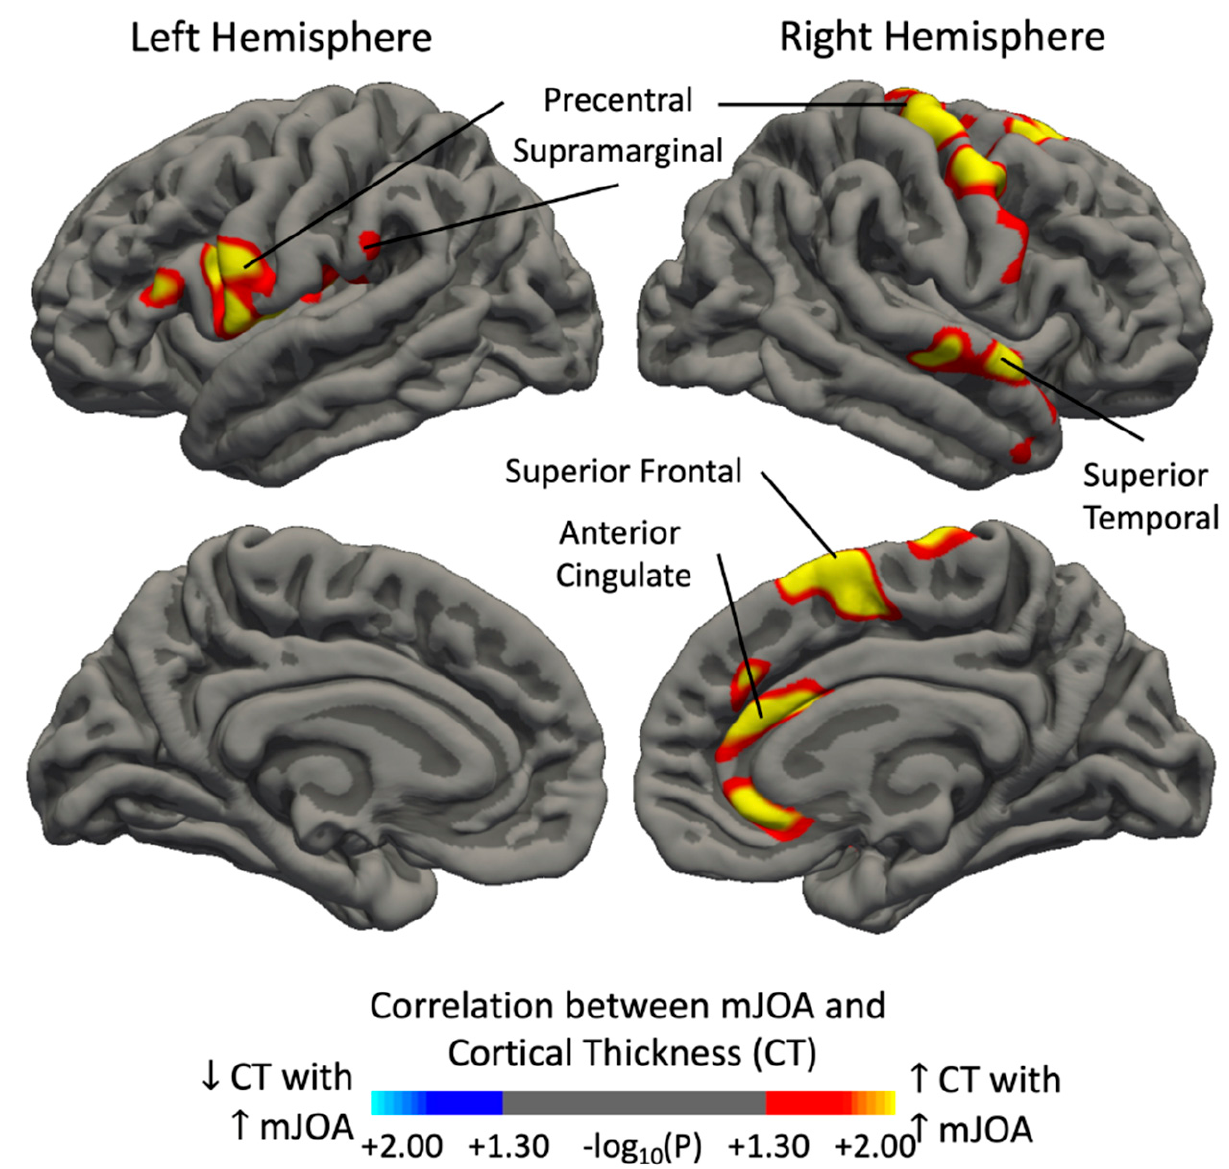
Figure 2. Regions demonstrating a strong association between the cortical thickness and mJOA score in a cohort of both patients and HCs. Red–yellow color denotes increasing cortical thickness/volume with better neurological status (increasing mJOA score), while blue–light blue color denotes decreasing cortical thickness/volume with better neurological status (increasing mJOA score). Significant clusters were determined by thresholding based on the level of statistical significance ( p < 0.05).